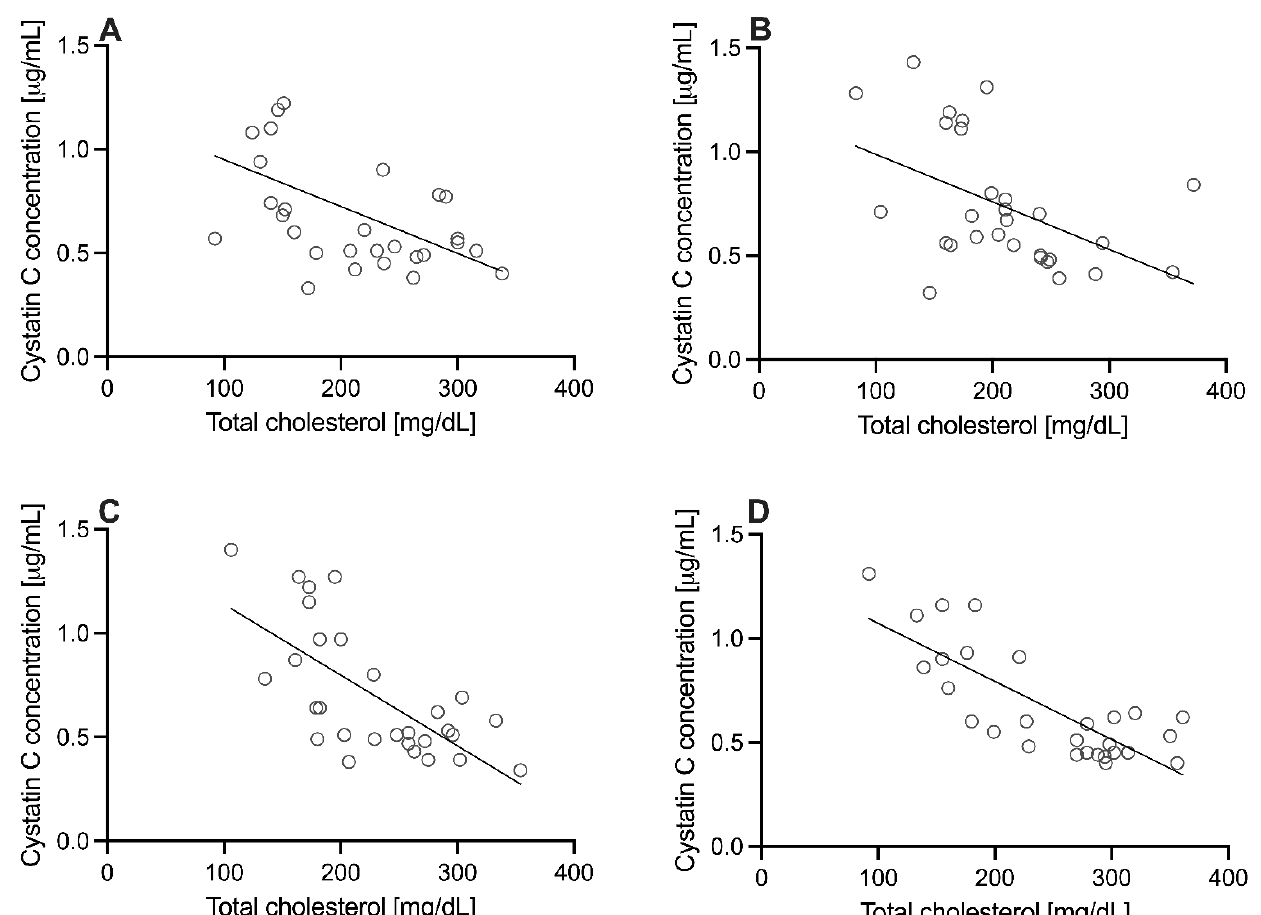
Figure 4. Scatterplots for correlations between cystatin C and total cholesterol in the COVID-19 group. ( A )—C1 time-point; ( B )—C7 time-point; ( C )—C14 time-point; ( D )—C28 time-point.